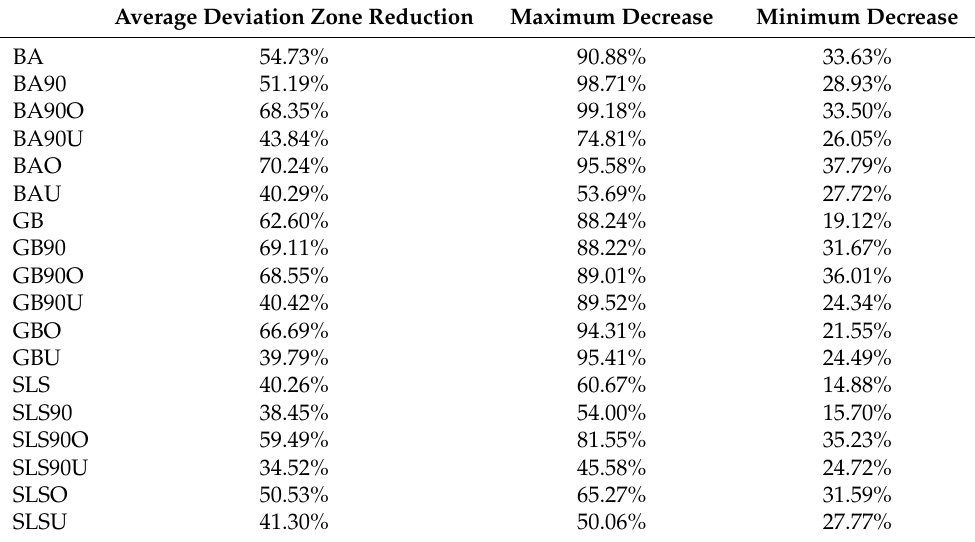
Table 1. Results for all